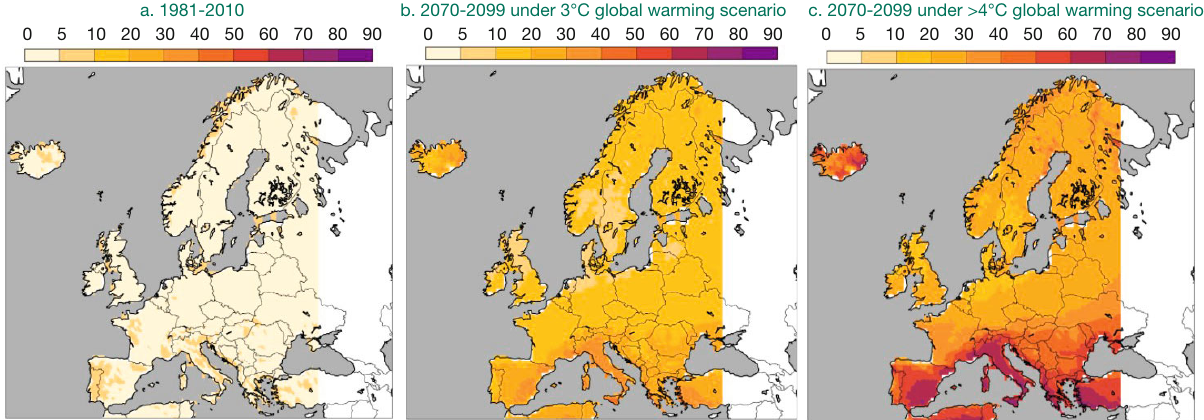
Annual number of health-aff ecting heatwave